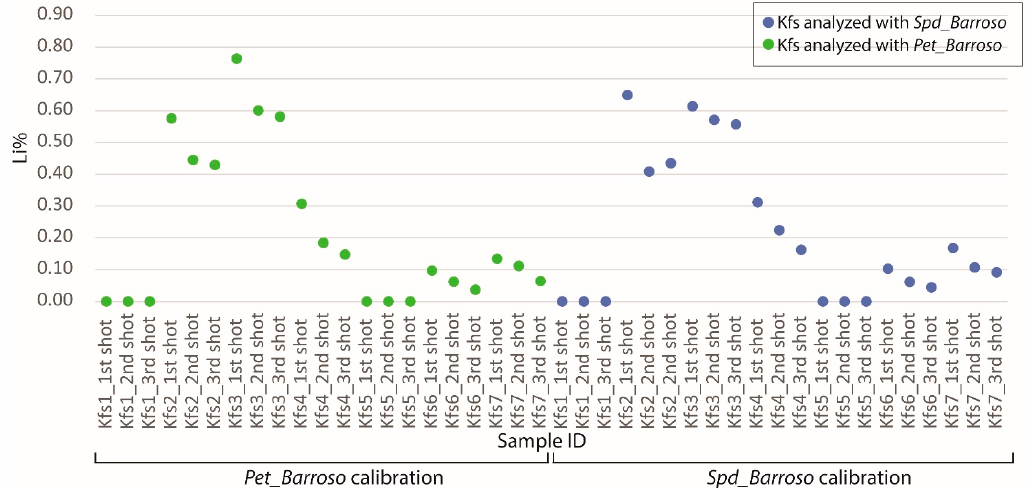
Figure 26. Li results from the pLIBS by analyzing three times seven distinct potassium felspars (Kfs) with the Pet_Barroso (green dots) and the Spd_Barroso (blue dots) calibrations.